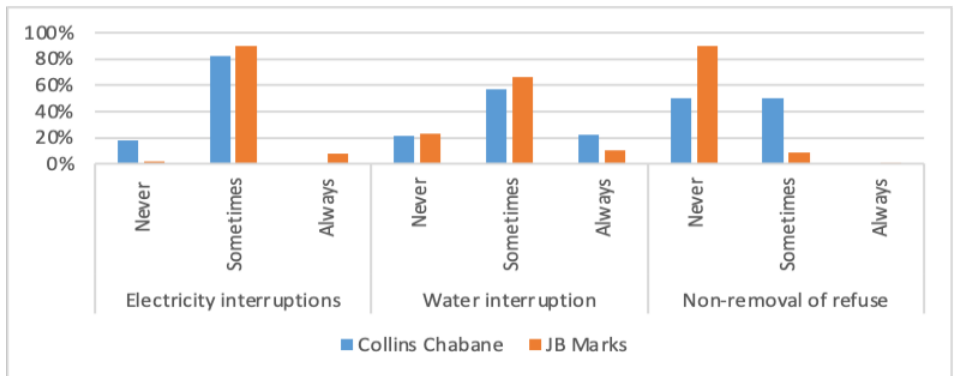
Figure 3: Experience with the level and quality of services provided by the municipality